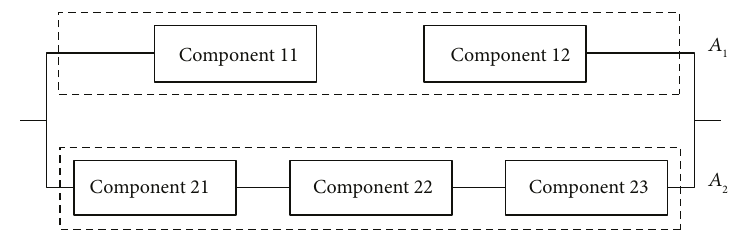
Figure 2: A warm standby redundant parallel-series system with two subsystems. Table 1: The data of the example.